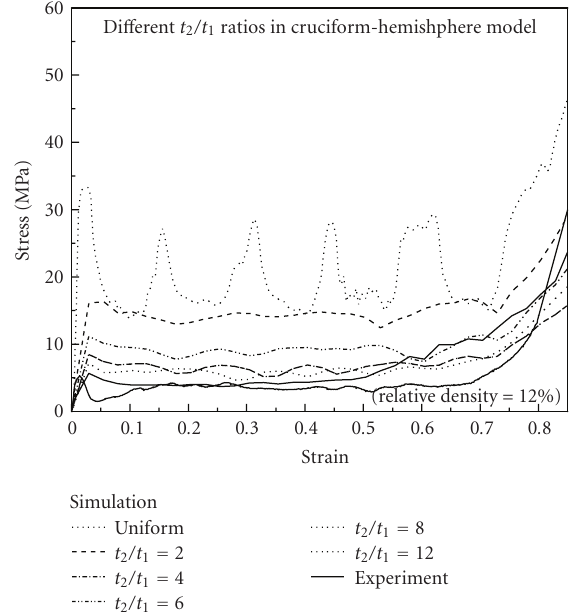
Figure 7: Experimental and simulated stress-strain curves using cruciform-hemisphere model, for a 12% relative density foam.